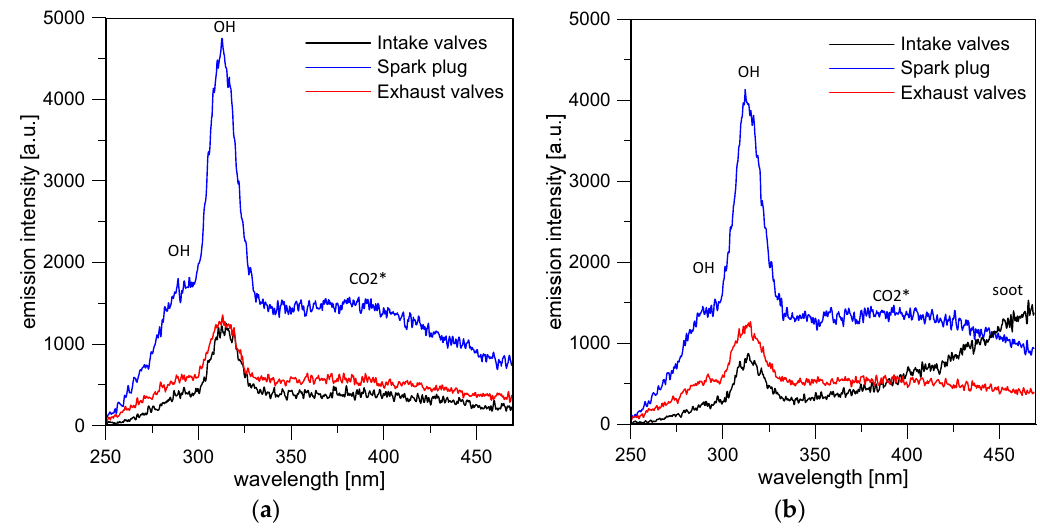
17 of 23 Figure 17. Evolution of the Heywood Circularity Factor, obtained by averaging data over 25 consecutive engine cycles. Following the combustion process throughout its progression, from around 20–35 CAD ASOS, the flames reached the optical limit in all investigated conditions. The emission spectra related to the burned gas evolved only in intensity and not in spectral behavior, as can be observed in Figure 18a for the stoichiometric condition. After this time, as shown in Figure 10, strong luminous flames were observed first systematically in the intake valves region and then in random locations near the walls. As observed in previous works [13,39,51,60], these flames were due to the diffusive combustion of stratified fuel in the injector region and on the piston surfaces. In terms of spectroscopic evidence (Figure 18b), these flames featured a continuous signal that increased with a wavelength similar to the blackbody curve described by Planck’s radiation law [61]. The oxidation of fuel deposits induced the formation of carbonaceous structures that formed soot by aggregation. Soot-specific emission